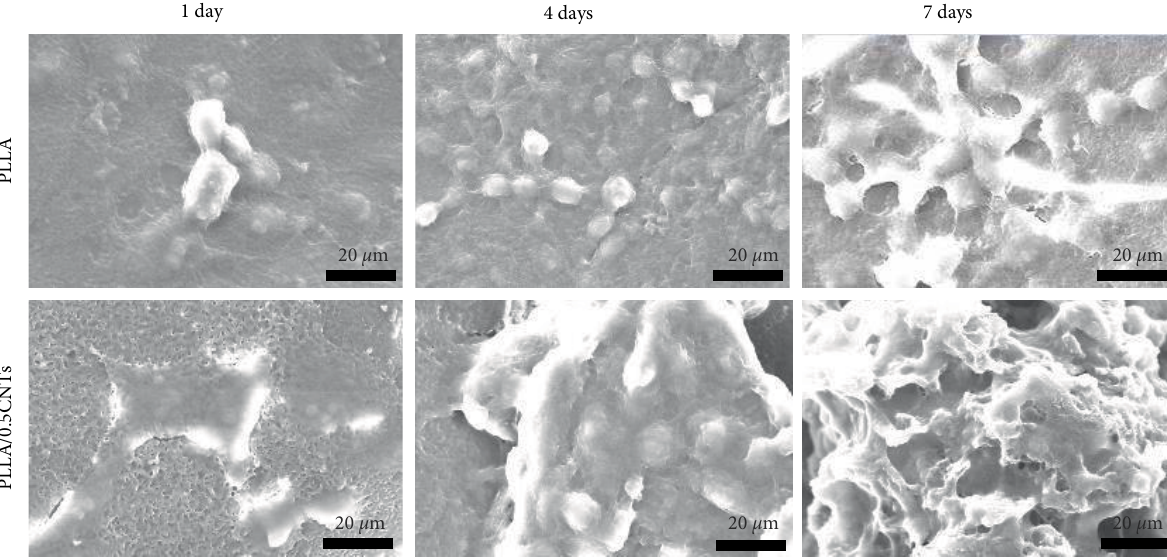
Figure 8: SEM images of the MG63 cells cultured on scaffolds for 1, 4 and 7